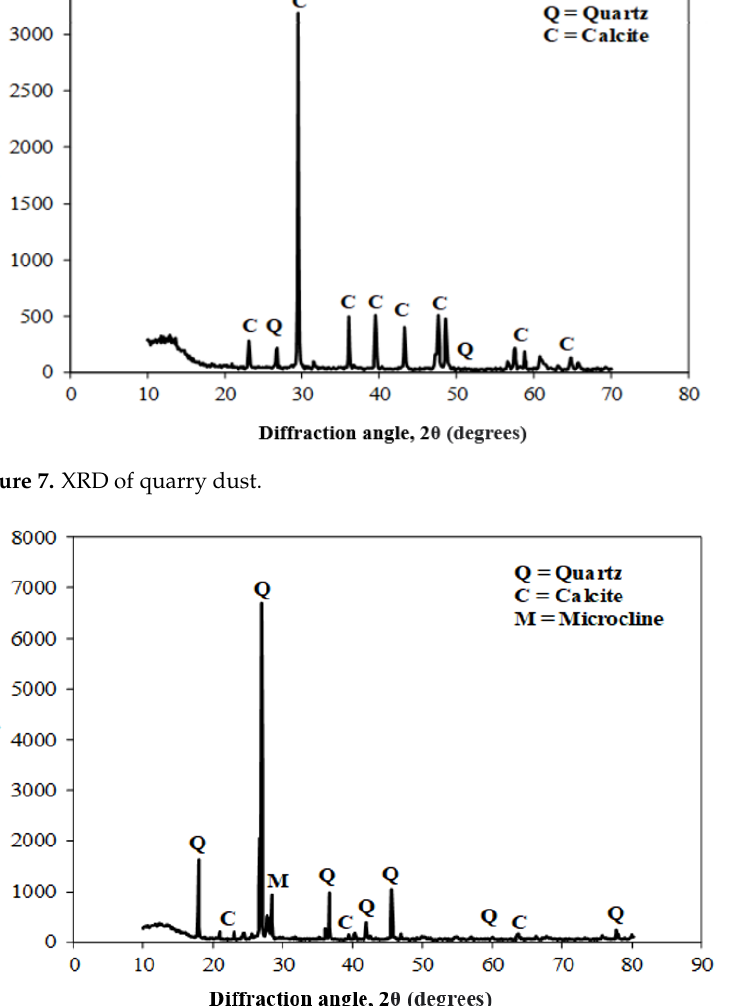
Figure 8. XRD of Lawrencepur sand.